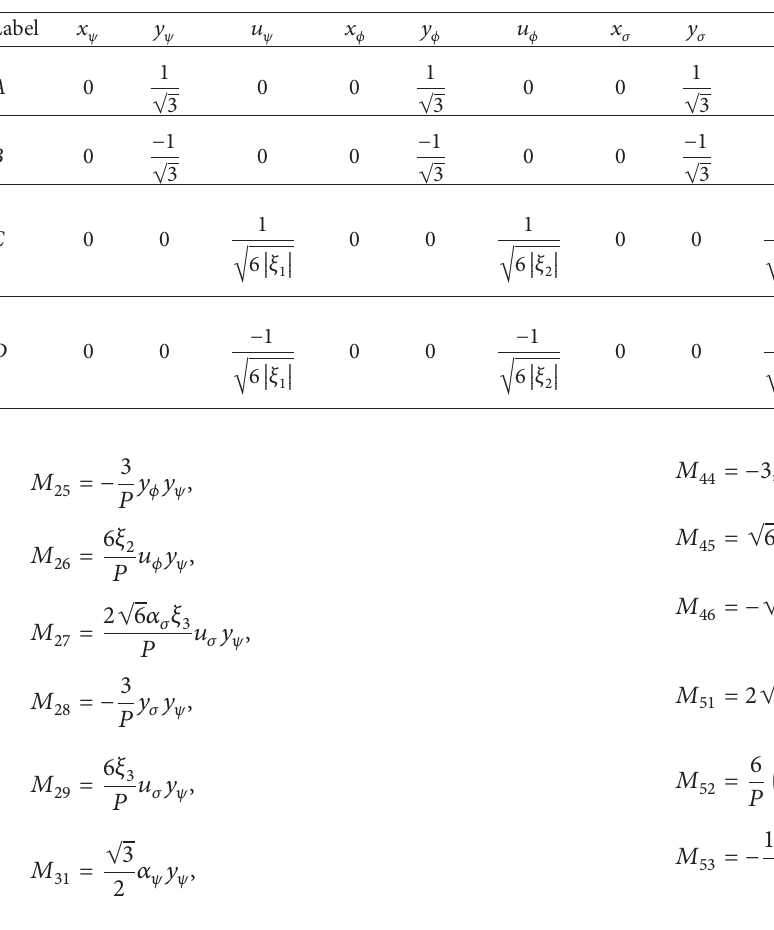
Figure 1: Two-dimensional projections of the phase-space trajectories for 𝜉 1 = 𝜉 2 = −𝜉 3 = 0.5 , 𝛼 𝜓 = 𝛼 𝜙 = −𝛼 𝜎 = 1.5 . All plots begin from the critical point 𝐴 being a stable attractor. Table 1: Critical points and existence